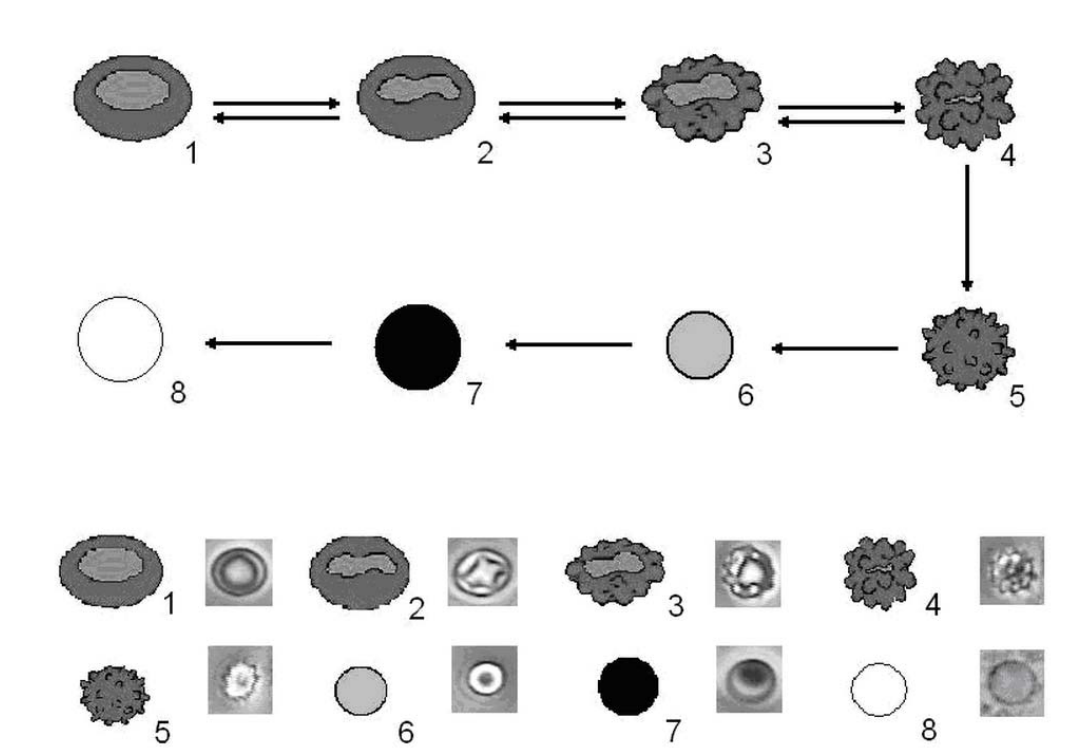
Fig. 1 Scheme of RBC transformation from a discocyte to a shadow corpuscle on inter- action with nanosilica: discocyte (1), echinocyte I-IV (2-5), spherocyte (6), and shadow corpuscle (7-8) shown with consideration for their relative